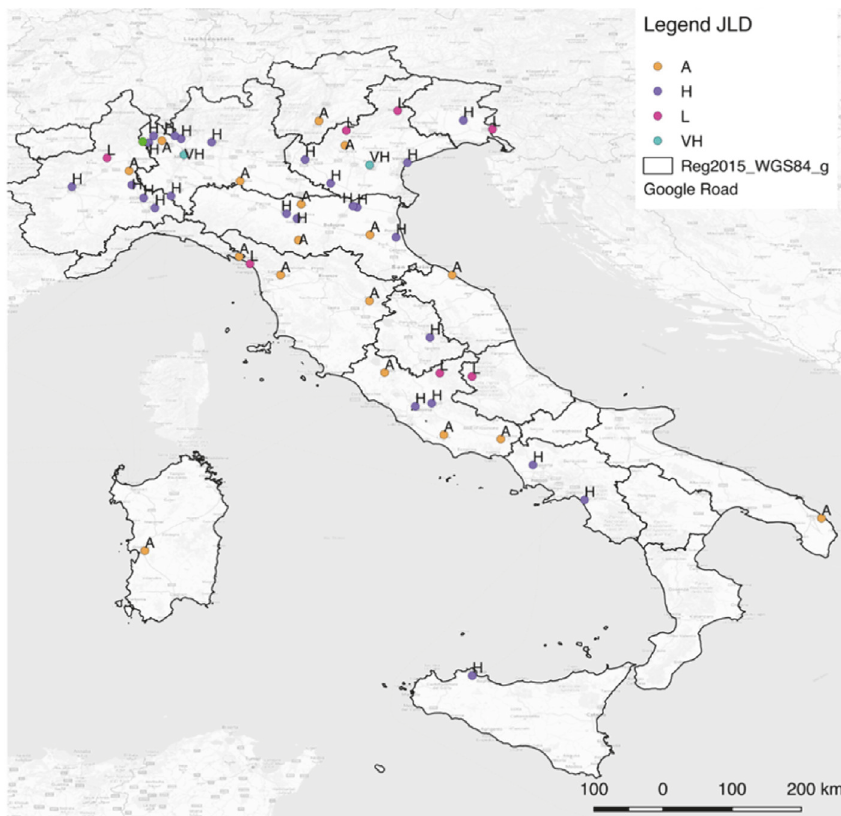
Figure 9: MCSDA implementation for JLD: spatial